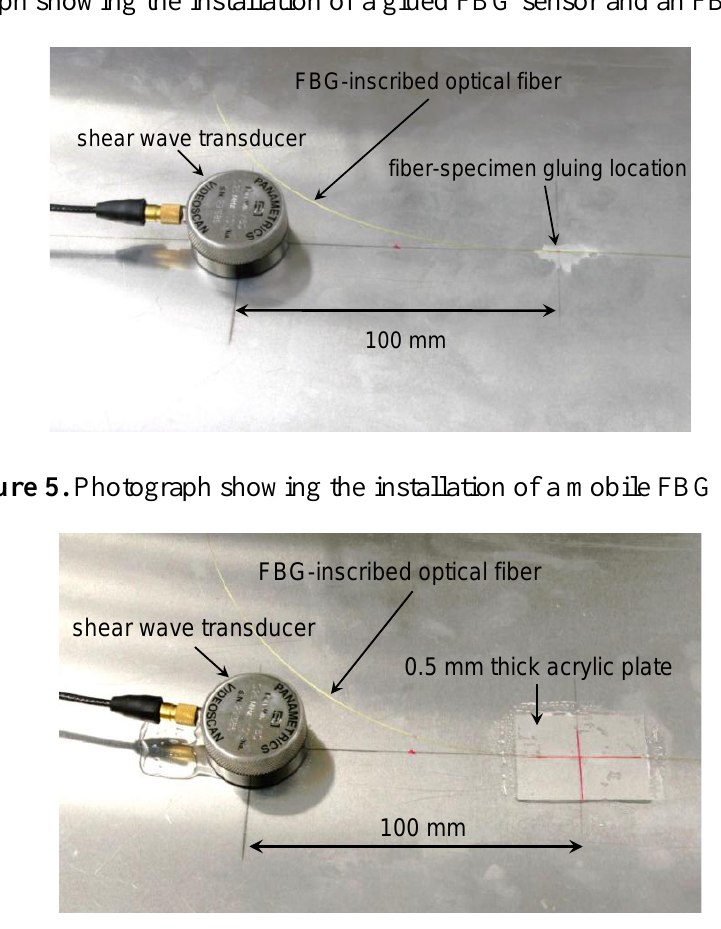
Figure 4. Photograph showing the installation of a glued FBG sensor and an FBG contact-free sensor.